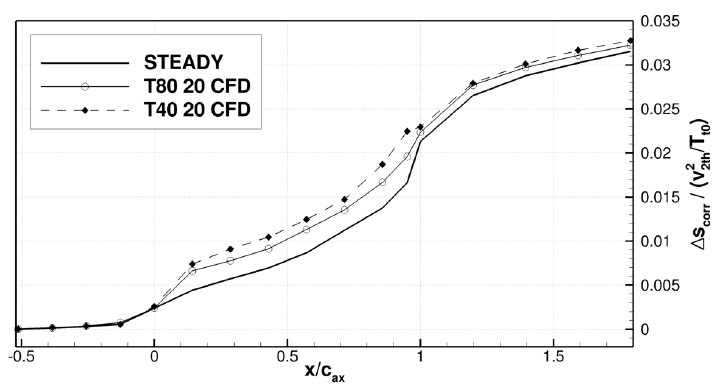
Figure 6. Comparison of the axial entropy development in the steady and the two investigated unsteady cases (T80 20 and T40